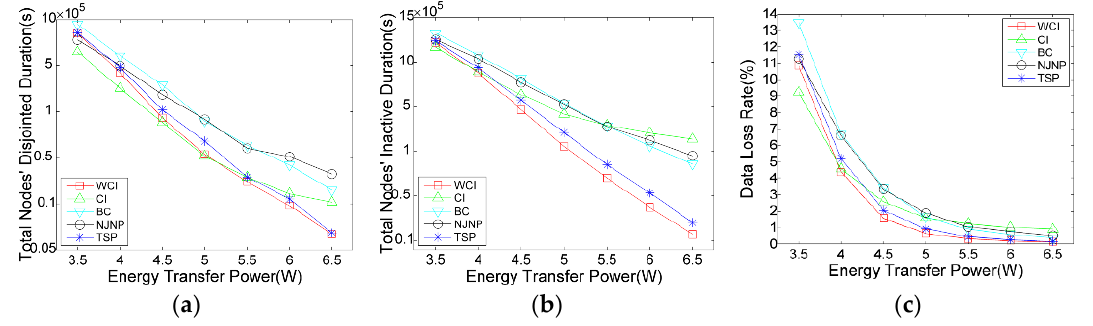
Figure 8. Impact of r p on the charging scheduling algorithms: ( a ) Total nodes’ disjointed time ; ( b ) Total nodes’ inactive time ; ( c ) Network’s data loss rate .